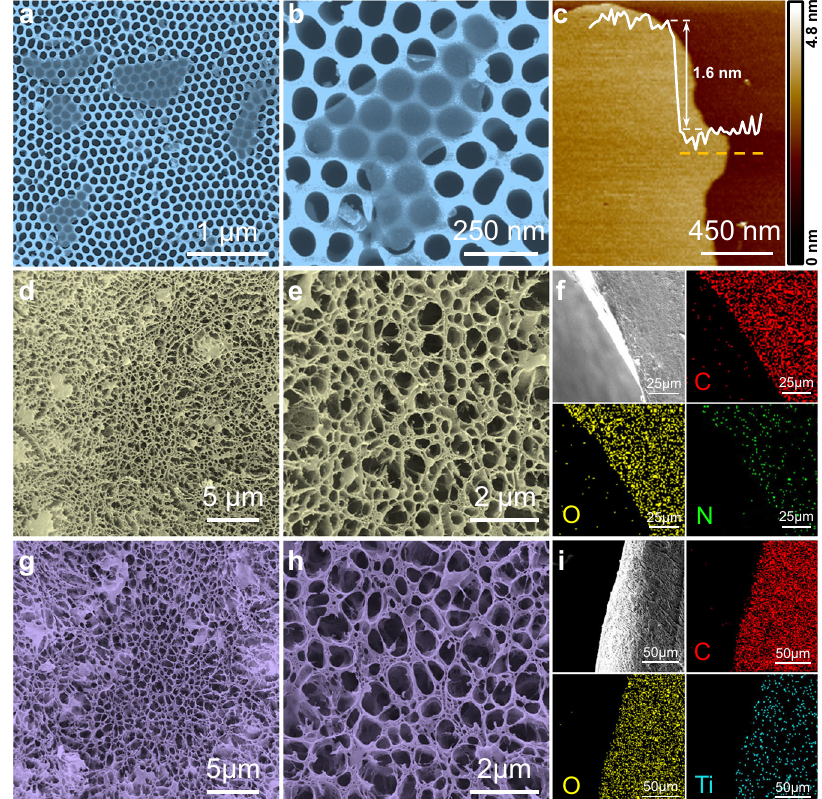
Fig. 2 Morphology and structure of materials. a , b Scanning electron microscope (SEM) morphology and ( c ) atomic force microscope (AFM) image of Ti 3 C 2 T x fl akes. Microstructure of ( d , e ) pristine lyophilized gel with ( f ) corresponding elements distribution. Microstructure of ( g , h ) Ti 3 C 2 T x loaded lyophilized gel with ( i ) elements